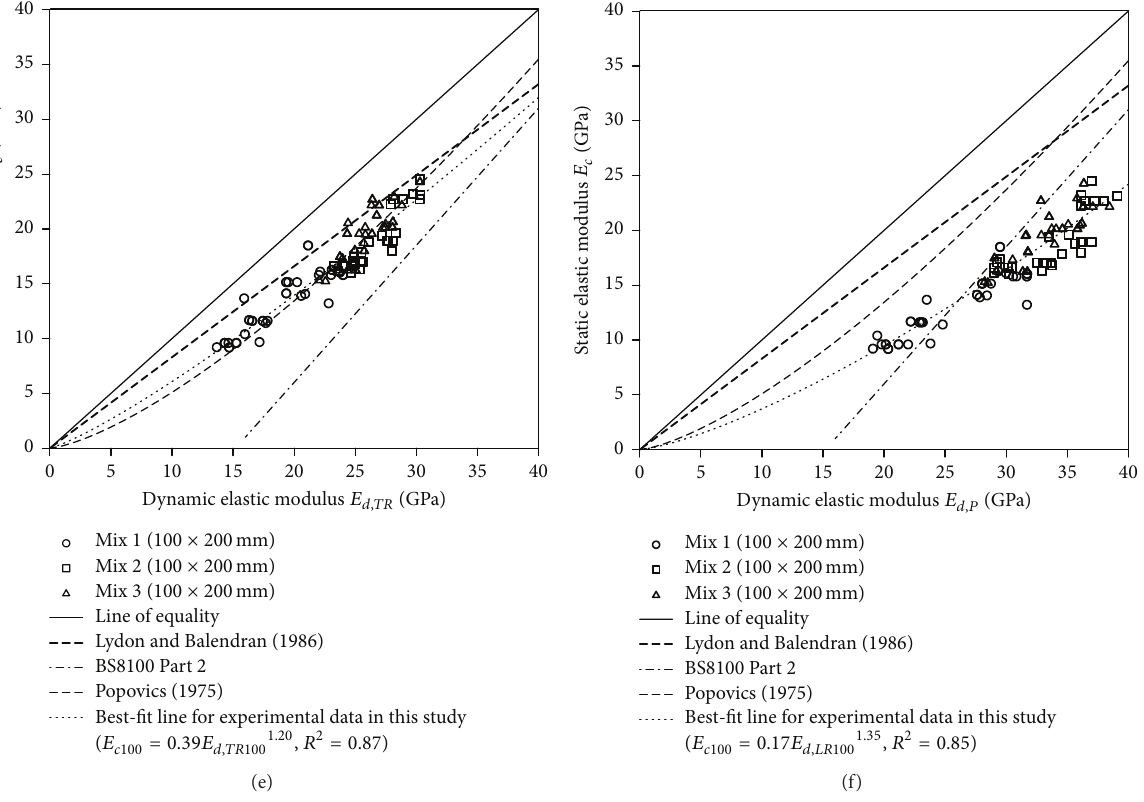
Figure 8: Comparison of static and resonance elastic moduli of concrete: (a) 𝐸 𝑑,𝐿𝑅150 versus 𝐸 𝑐,150 , (b) 𝐸 𝑑,𝑇𝑅150 versus 𝐸 𝑐,150 , (c) 𝐸 𝑑,𝑃150 versus 𝐸 𝐸 𝐸 𝐸 𝐸 𝐸 𝐸 𝑐,150 , (d) 𝑑,𝐿𝑅100 versus 𝑐,100 , (e) 𝑑,𝑇𝑅100 versus 𝑐,100 , and (f) 𝑑,𝑃100 versus 𝑐,100 .